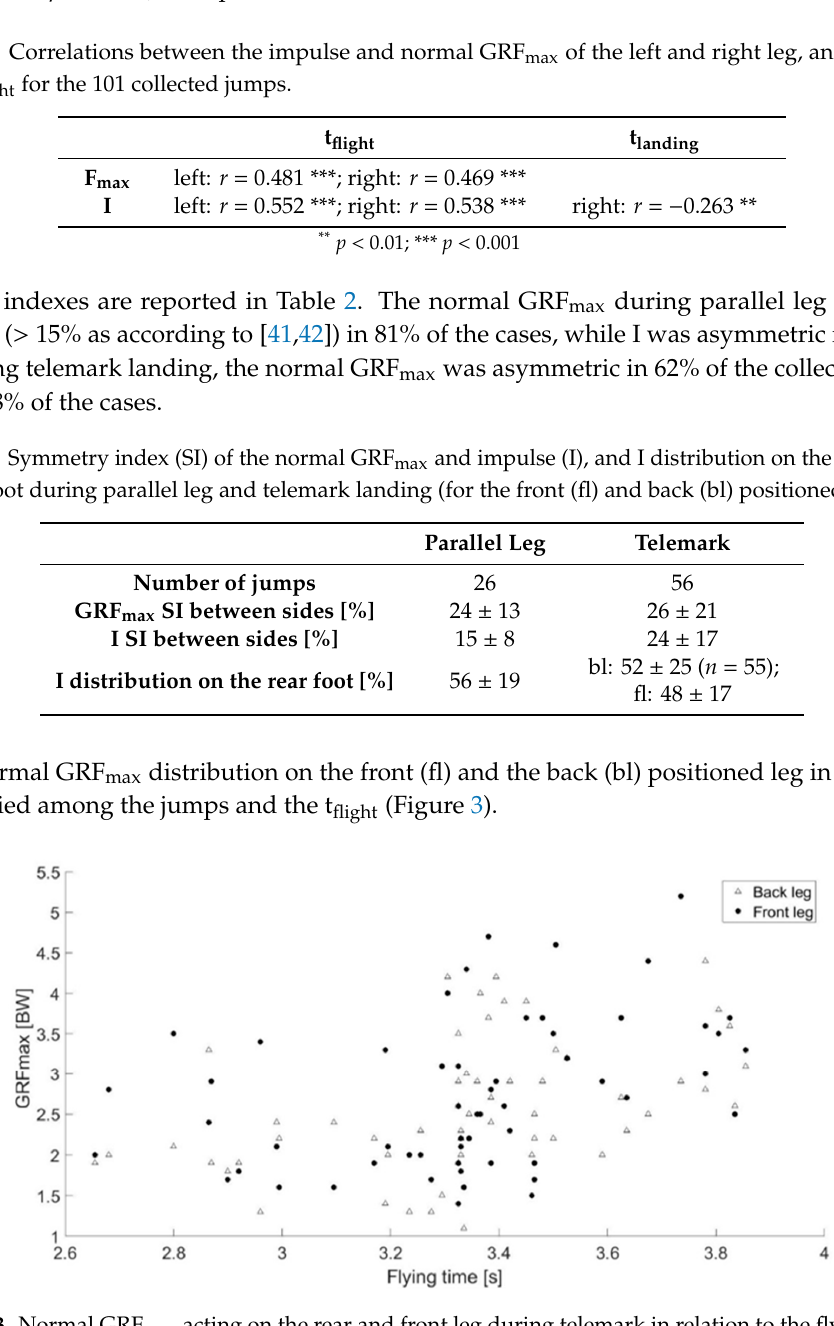
Table 1. Correlations between the impulse and normal GRF max of the left and right leg, and t landing and t flight for the 101 collected jumps.